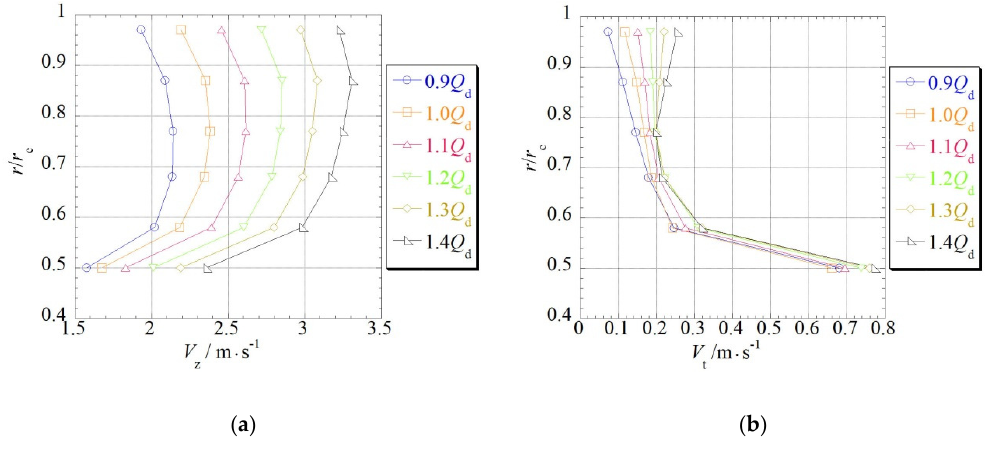
Figure 10. The front rotor axial velocity and circumferential velocity of new model: ( a ) Axial velocity; ( b ) Circumferential velocity.